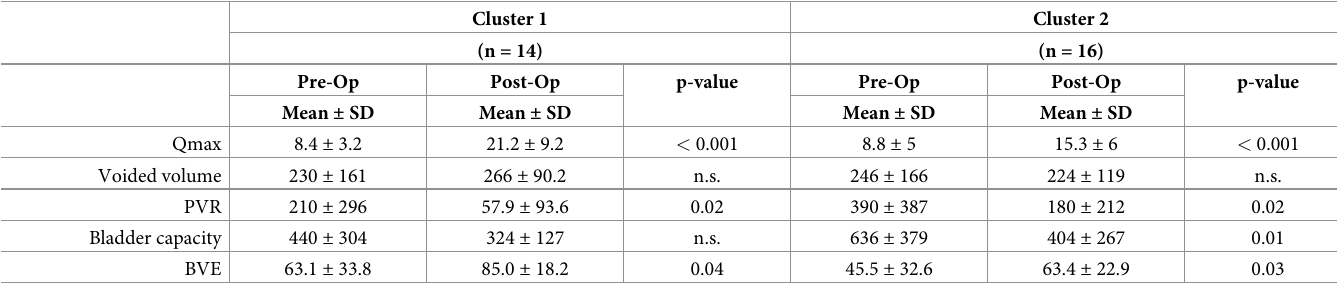
Table 2. Pre-operative and post-operative voiding metrics in representative subsets of patients in Clusters 1 and